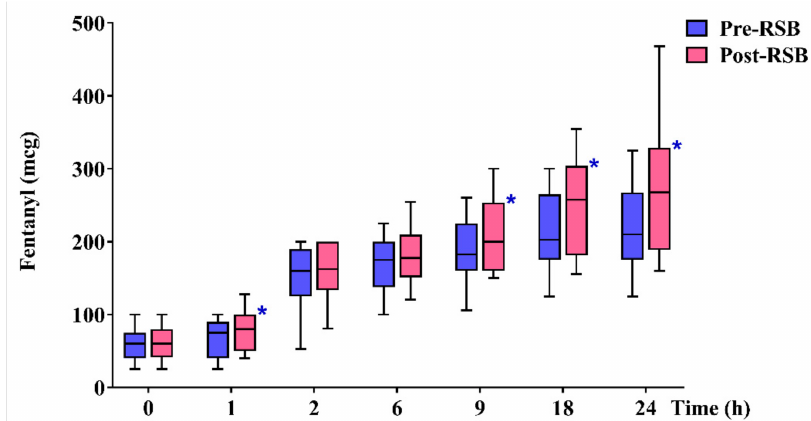
Figure 2. Cumulated rescue analgesic consumption during 24 h after surgery. Data are expressed as median (interquartile range). Horizontal lines, boxes, and error bars represent the median, interquartile range, and 10th and 90th percentile, respectively. * p < 0.05. Abbreviations: Pre-RSB, preoperative rectus sheath block; Post-RSB, postoperative rectus sheath block.